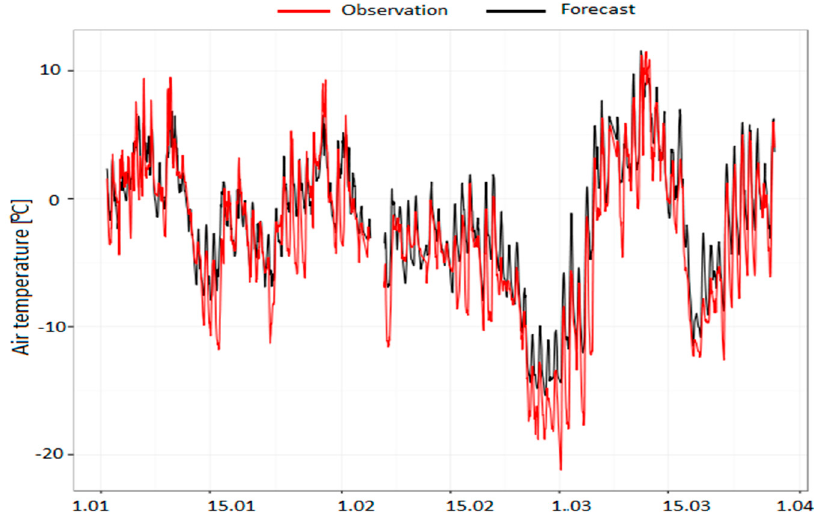
Figure 10. Measured and modeled values of air temperature (2 m above the ground) at Zakopane station for the period 1 January to 30 April 2018 for AROME CMC 2 km.